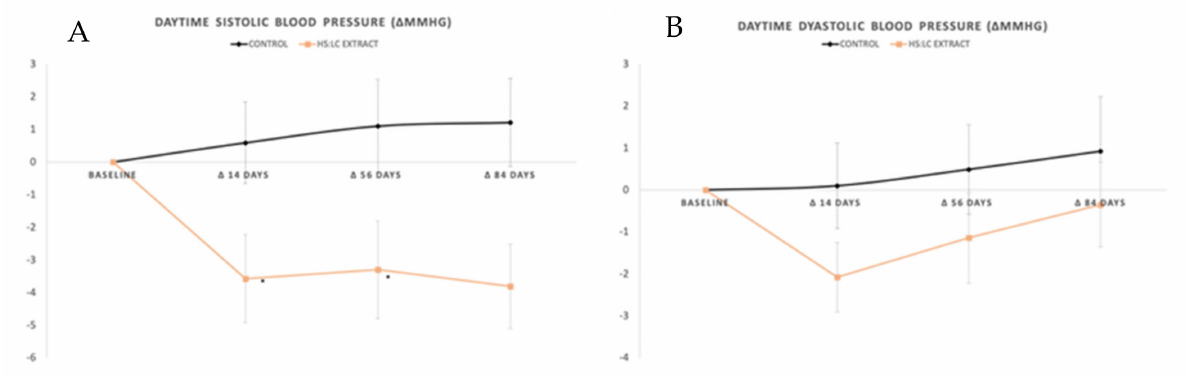
Figure 2. ( A ) Systolic blood pressure and ( B ) diastolic blood pressure determined using ambulatory blood pressure monitoring (ABPM). Represents statistically significant intragroup differences. Values are expressed by the increase (in mmHg) between the baseline and each control